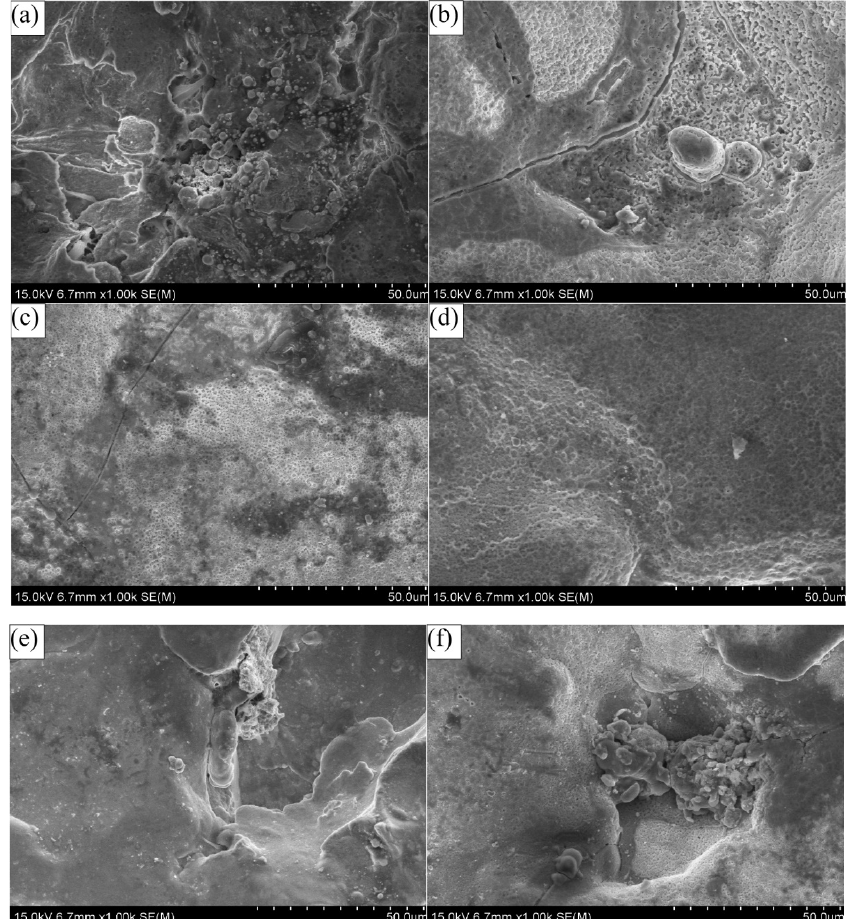
Figure 13. Surface morphologies after the corrosion of composite coatings with different particle concentrations prepared on 45 steel substrates through scanning electrodeposition. (( a ) 0, ( b ) 1, ( c ) 2, ( d ) 3, ( e ) 4, and ( f ) 5 g·L − 1 ).